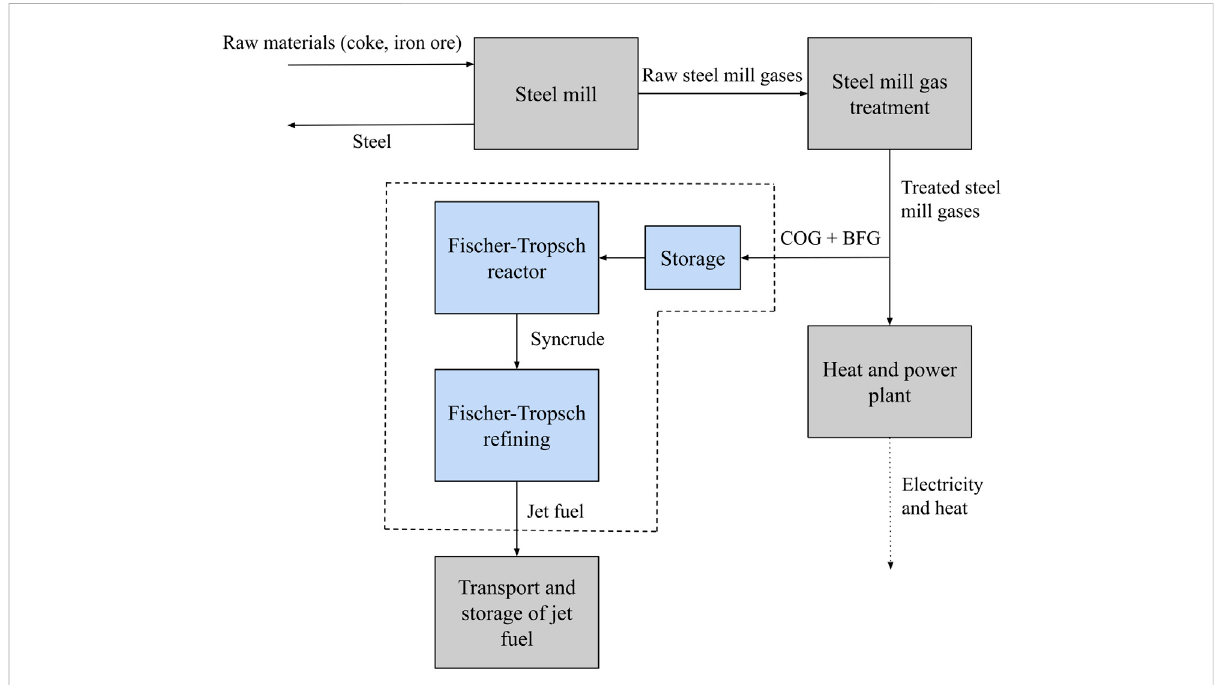
FIGURE 3 Thescope ofthestudy(theareaindashedlines) inthecontextofthelarger supplychain. Essentially,thescopeisfromwhensteelmillgases are captured before combustion in the heat and power plant until when market-ready jet fuel is